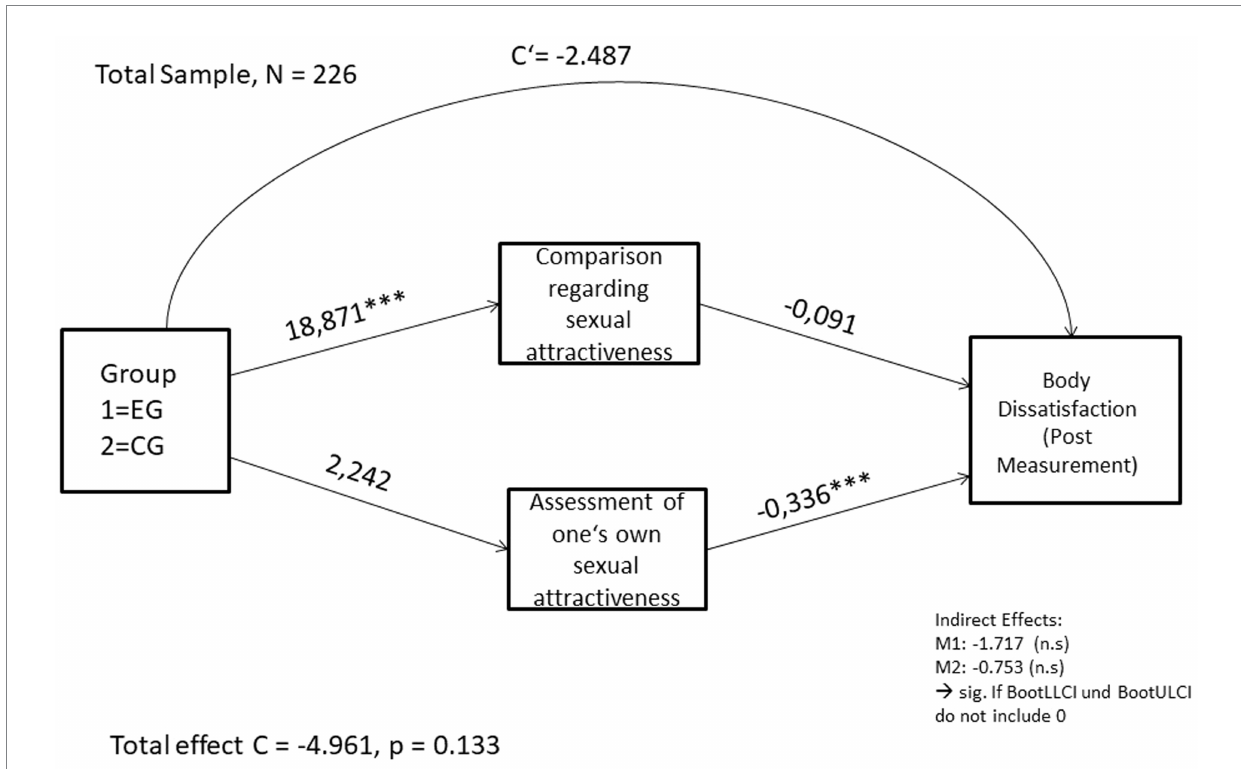
FIGURE 1 Calculated mediation model with direct effect and path effects. The asterisks behind the coefficients indicate the significance level: *** p <